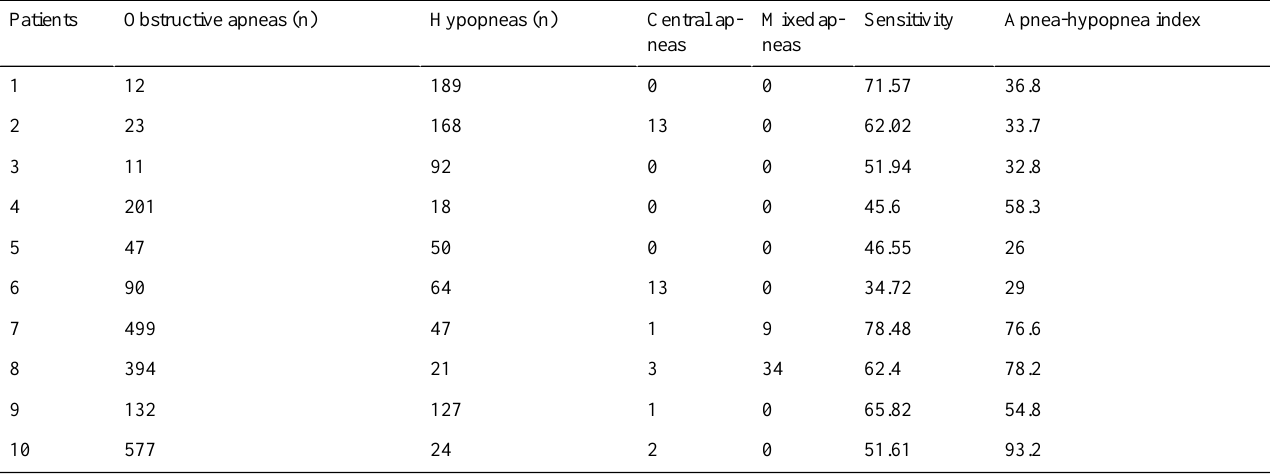
Table 7. The counts of the different apneic events for each patient versus achieved sensitivity and the manually scored apnea-hypopnea